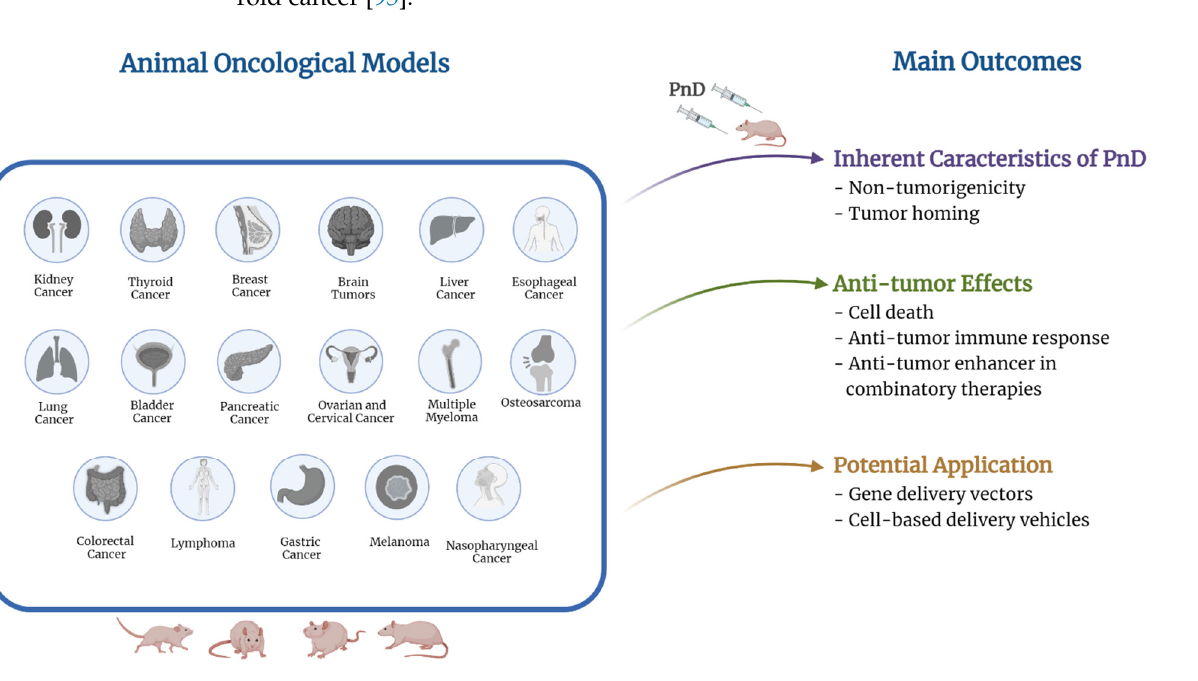
Figure 2. Summary of the animal oncological models for which the anticancer effects of PnD have been assessed and the main outcomes observed.